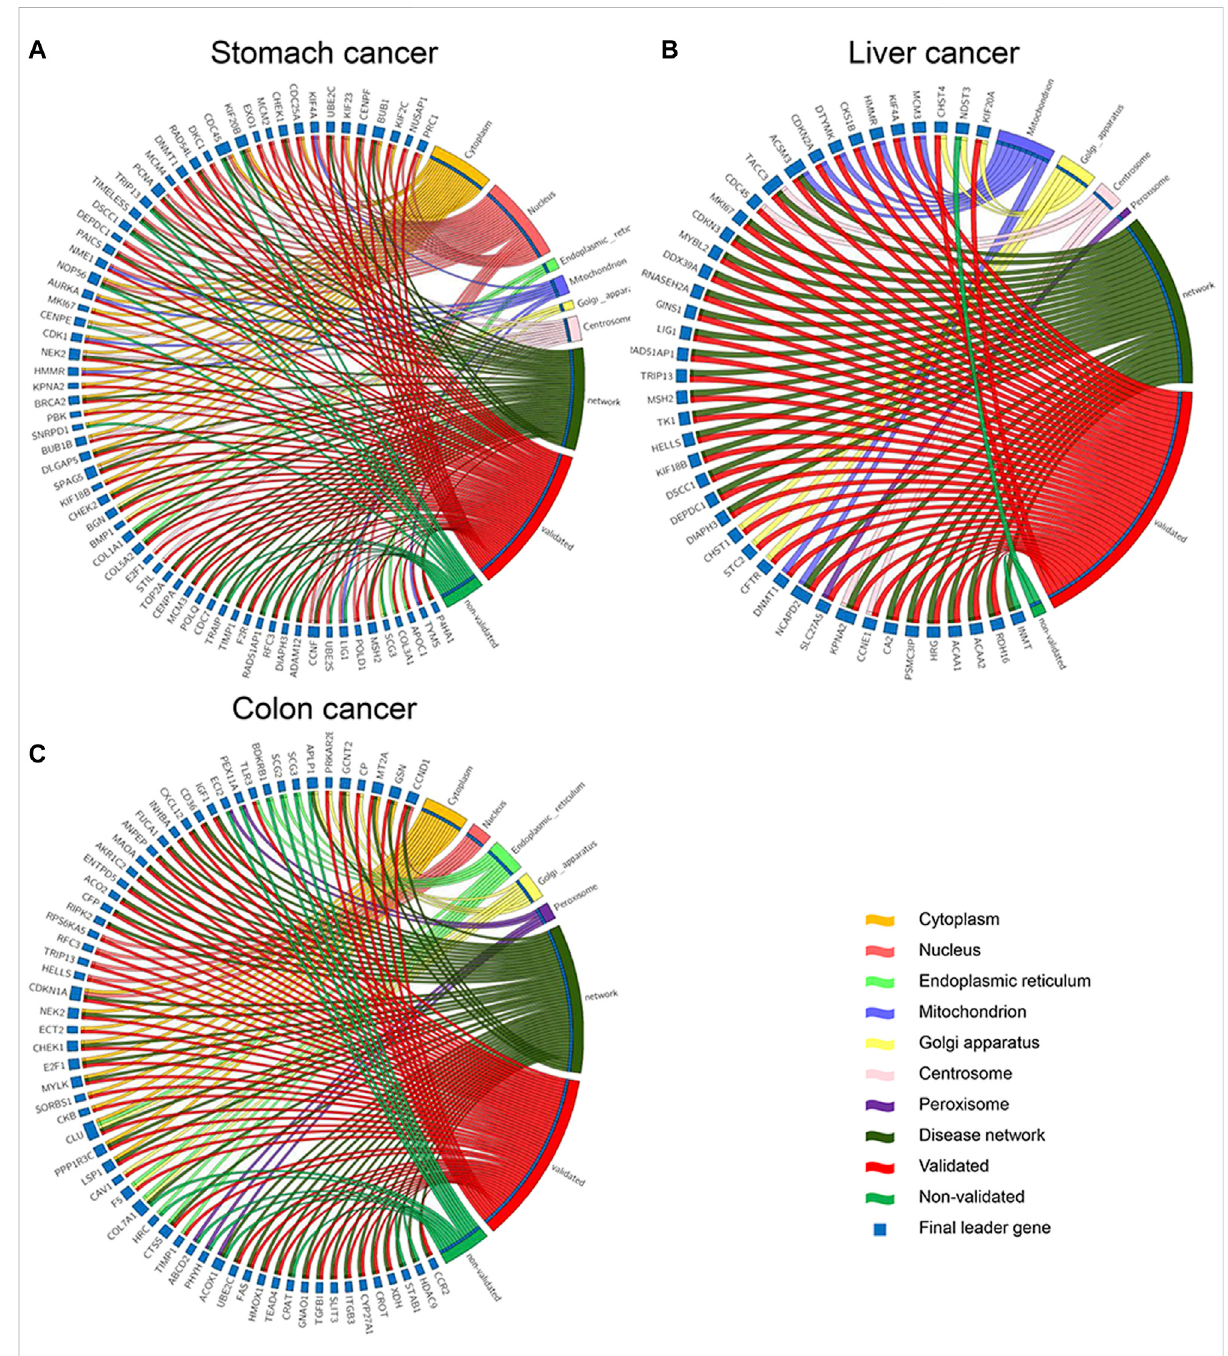
FIGURE 8 Literature review and subcellular location for fi nal leader genes. Red represents validated and green represents for not validated genes. (A) Stomach cancer. (B) Liver cancer. (C) Colon